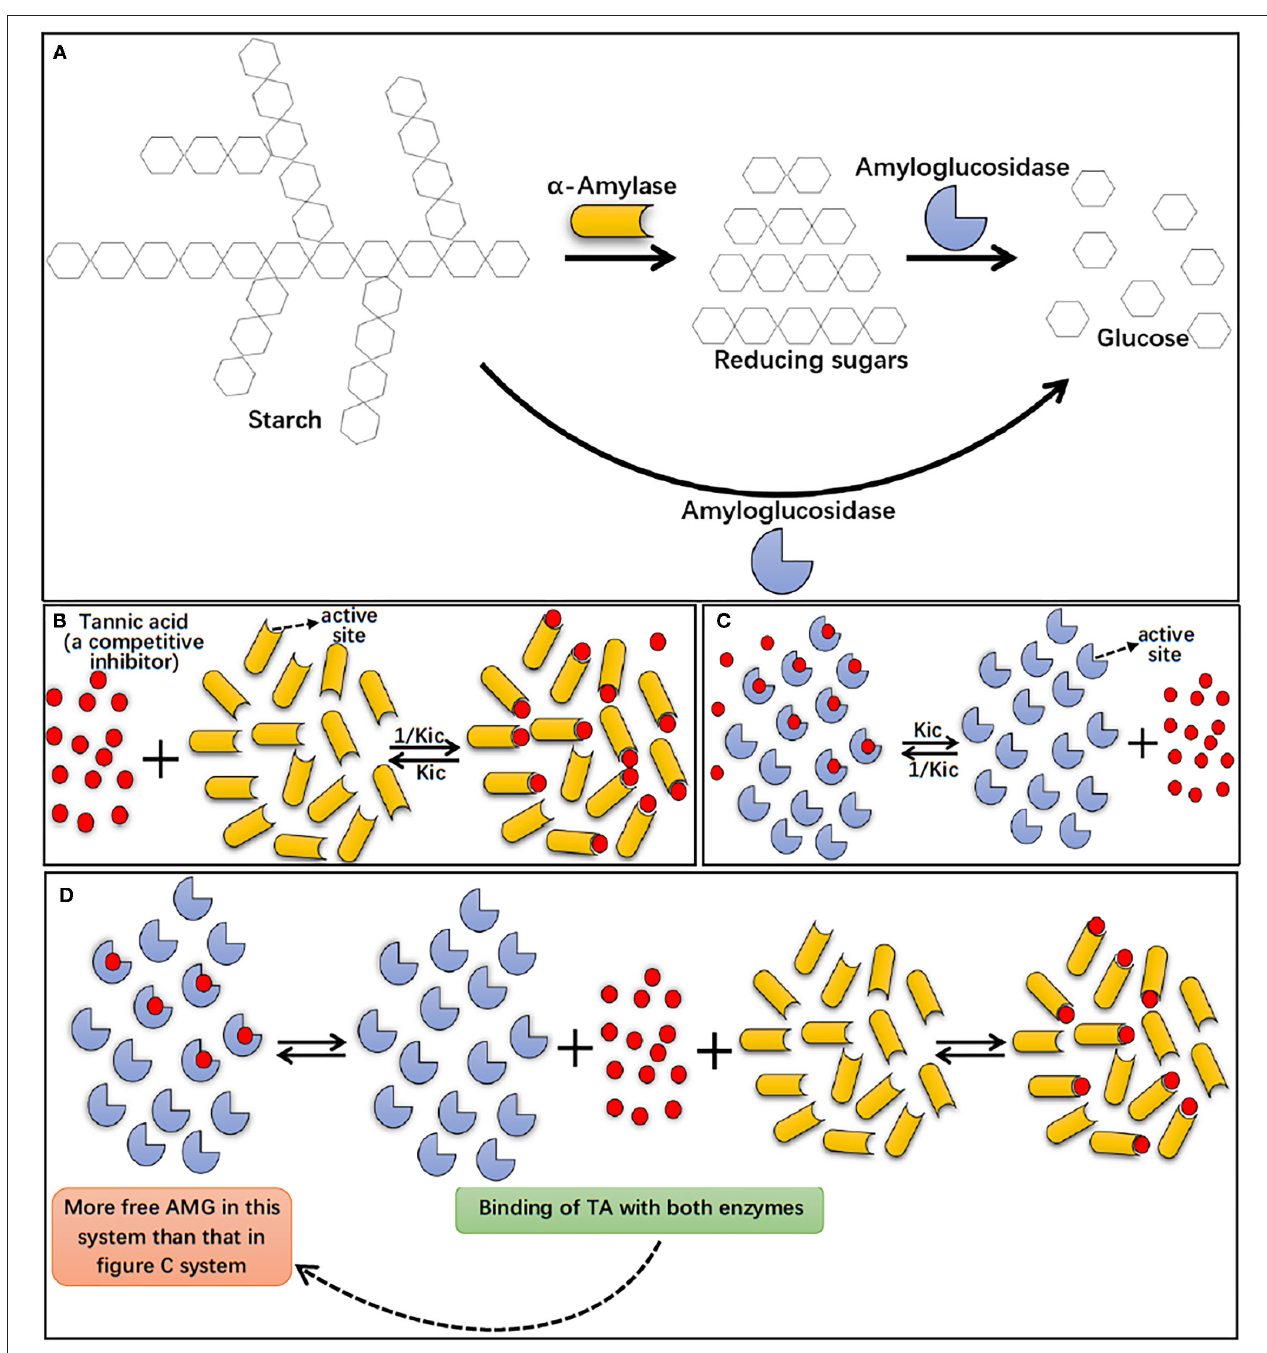
FIGURE 7 | Starch digestion processes by AA and AMG, in which AA hydrolyzes starch to reducing sugars (maltose, maltotriose, maltooligosaccharides, etc .), while AMG is able to hydrolyze both starch and reducing sugars to glucose (A) . The binding interactions of TA with individual AA (B) and AMG (C) , and the binding interactions occurred in AA/AMG bi-enzyme system in the presence of TA (D) . Specifically, TA was a specific competitive inhibitor of both AA and AMG, indicating that the polyphenol bound with the active sites of the enzymes, competing with starch molecules (substrate). Here, K ic indicates the dissociation constant of the TA-enzyme complex, and thus 1/ K ic suggests the association constant of TA with the enzyme. As suggested by inhibition kinetics and ITC, TA was shown with a higher binding affinity to AA than to AMG, as shown in (B,C) by the more TA molecules bound with AA than with AMG. In addition, in AA/AMG bi-enzyme system, binding interactions occurred both between TA and AA and between TA and AMG, this caused the more “free” AMG molecules without binding with TA in AA/AMG bi-enzyme system than that in individual AMG system (as shown in C,D ).